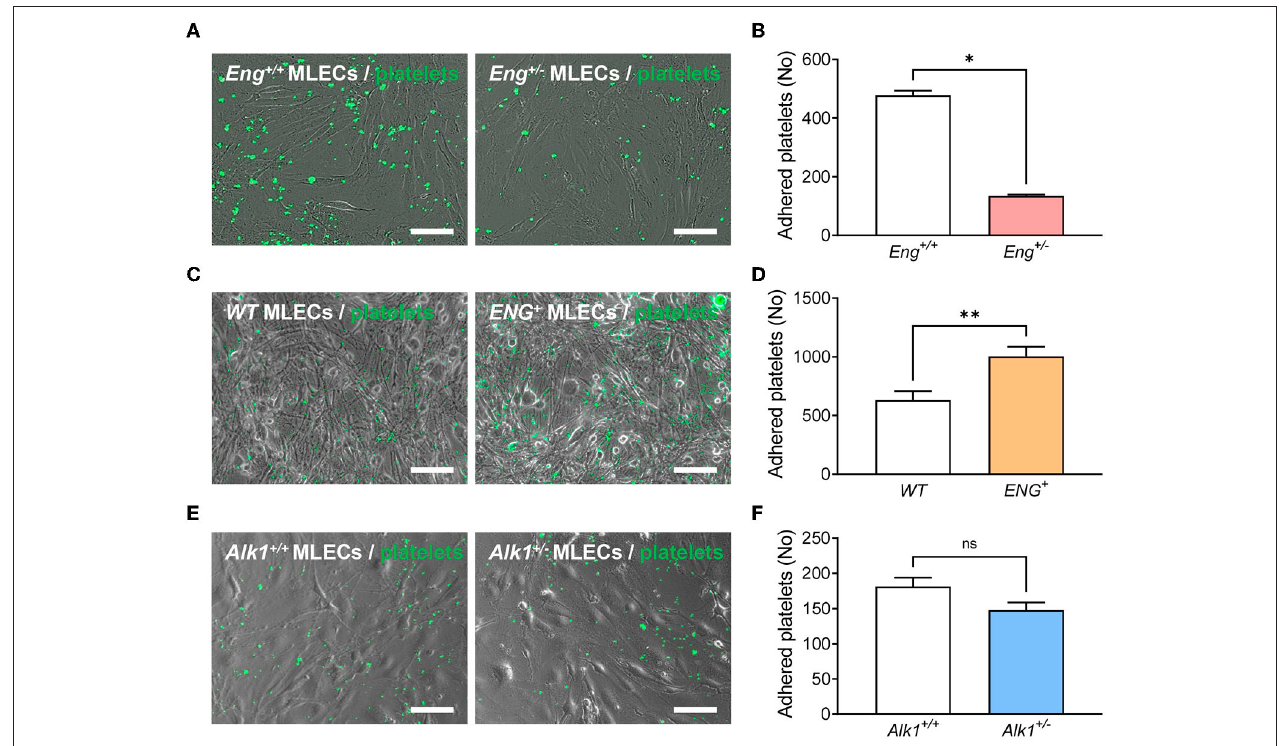
FIGURE 4 | (A) Representative images of calcein-labeled platelets (green fluorescence) adhered on a monolayer of endothelial cells (phase contrast image), isolated from Eng + / + or Eng + / − mice, treated with CXCL12. (B) Number of adherent platelets after 30min of incubation of platelets on CXCL12-activated endothelial cells isolated from Eng + / + or Eng + / − mice ( n = 4). (C) Representative images of calcein-labeled platelets (green fluorescence) adhered on a monolayer of endothelial cells (phase contrast image), isolated from WT or ENG + mice, treated with CXCL12. (D) Number of adherent platelets after 30min of incubation of platelets on CXCL12-activated endothelial cells isolated from WT or ENG + mice ( n = 9). (E) Representative images of calcein-labeled platelets (green fluorescence) adhered on a monolayer of endothelial cells (phase contrast image), isolated from Alk1 + / + or Alk1 + / − mice, treated with CXCL12. (F) Number of adherent platelets after 30min